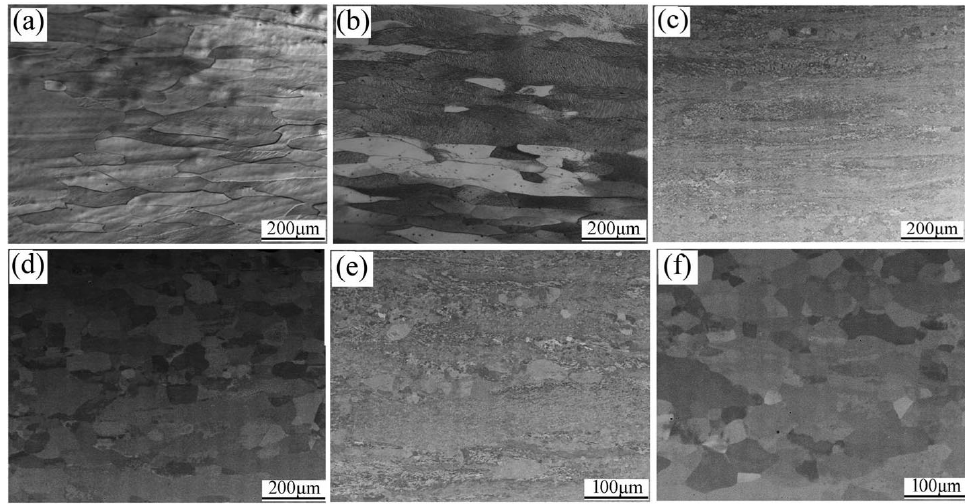
Figure 4. ECC image of 350 °C ( a ) CR-50%, V = 60 °C/min; ( b ) CR-50%, V = 100 °C/min; ( c ) CR-70%, V = 60 °C/min; ( d ) CR-70%, V = 100 °C/min; ( e ) CR-85%, V = 60 °C/min; ( f ) CR-85%, V = 100 °C/min.